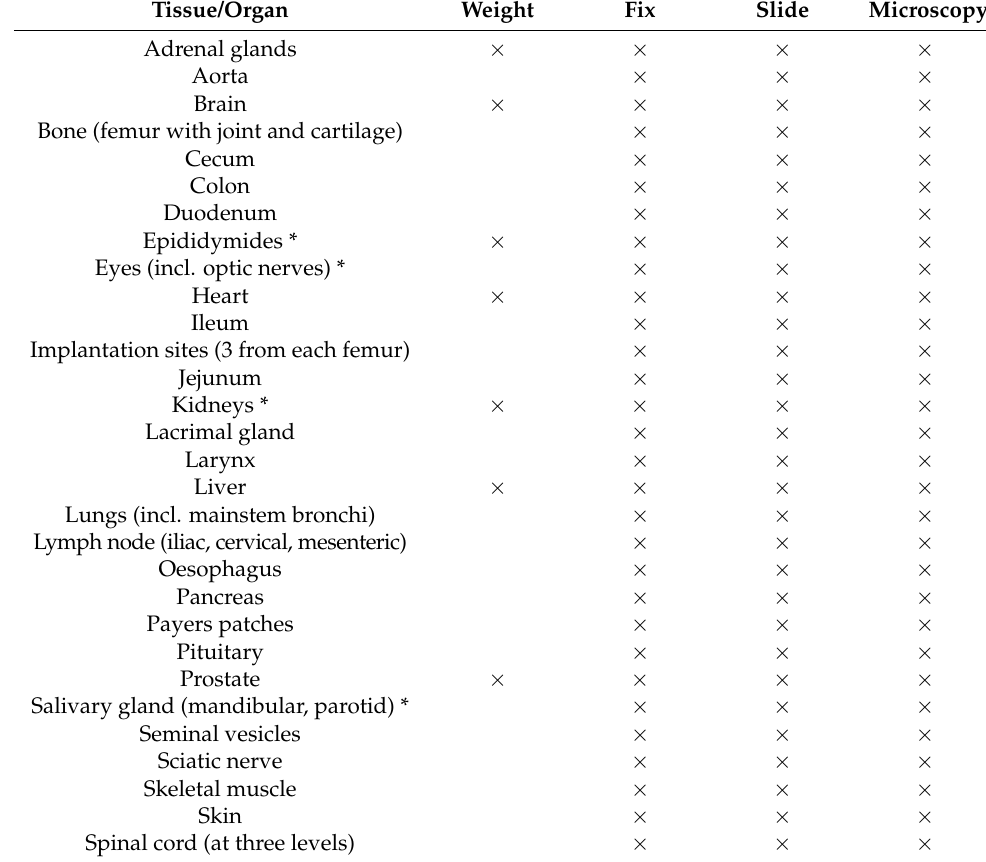
Table 1. Organs with histopathology